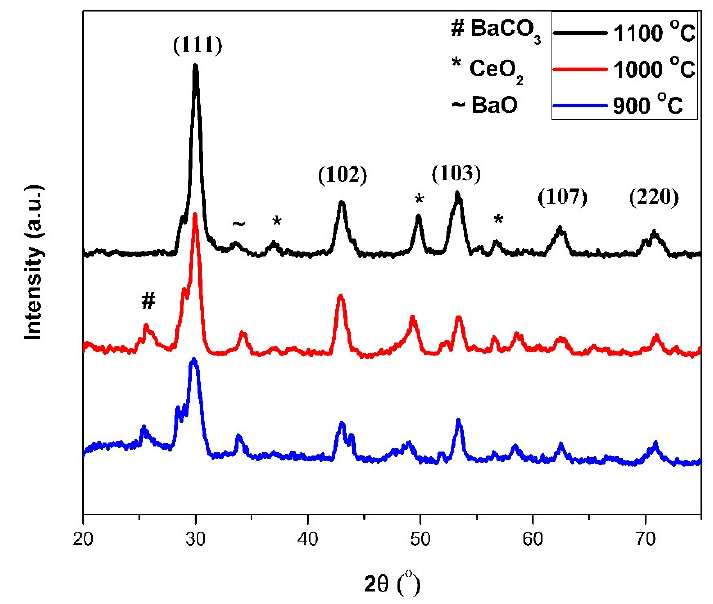
Figure 1. XRD spectra of sintered BaCe 0.2 Zr 0.6 Y 0.2 O 3−δ electrolyte